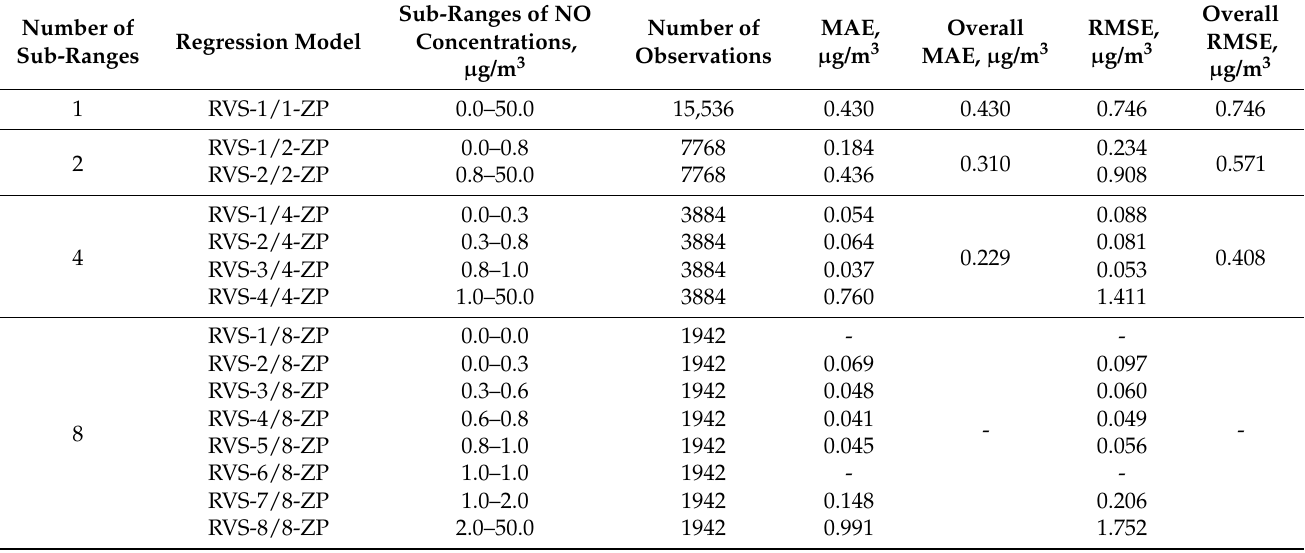
Table 10. Values of approximation errors of NO concentrations in RVS models, Złoty Potok